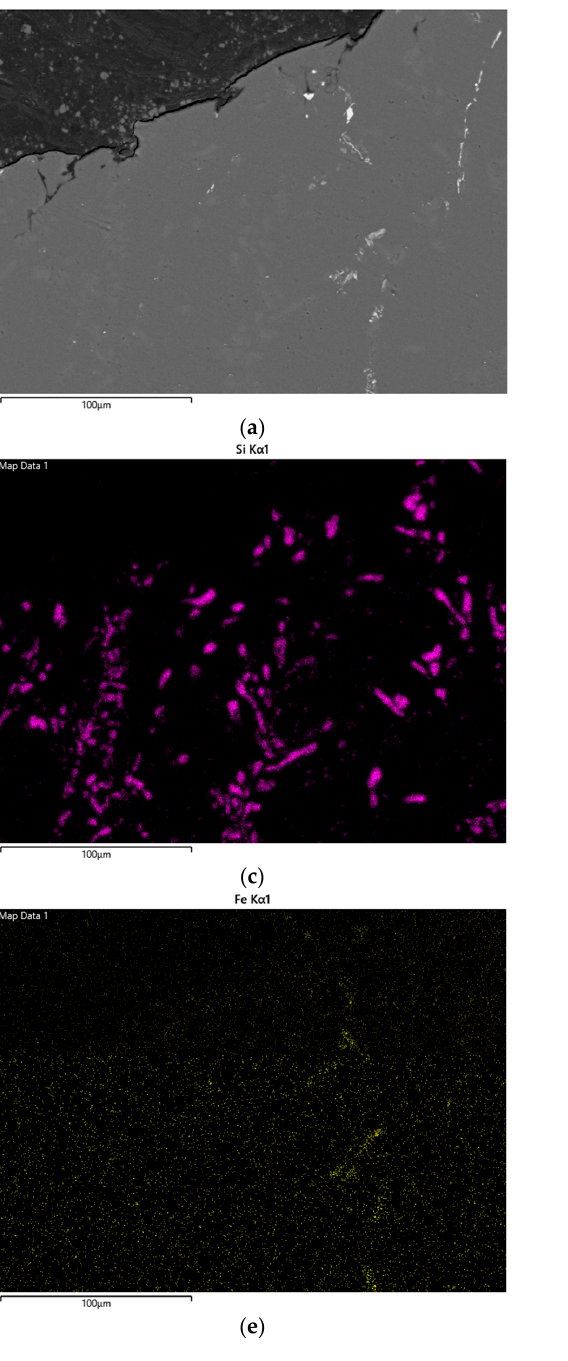
Figure 7. SEM BSE micrograph ( a ) and corresponding EDS map for the alloying elements (Al ( b ), Si ( c ), Er ( d ), Fe ( e ) and Mg ( f )) in the longitudinal section of E3 alloy close to its final fracture.